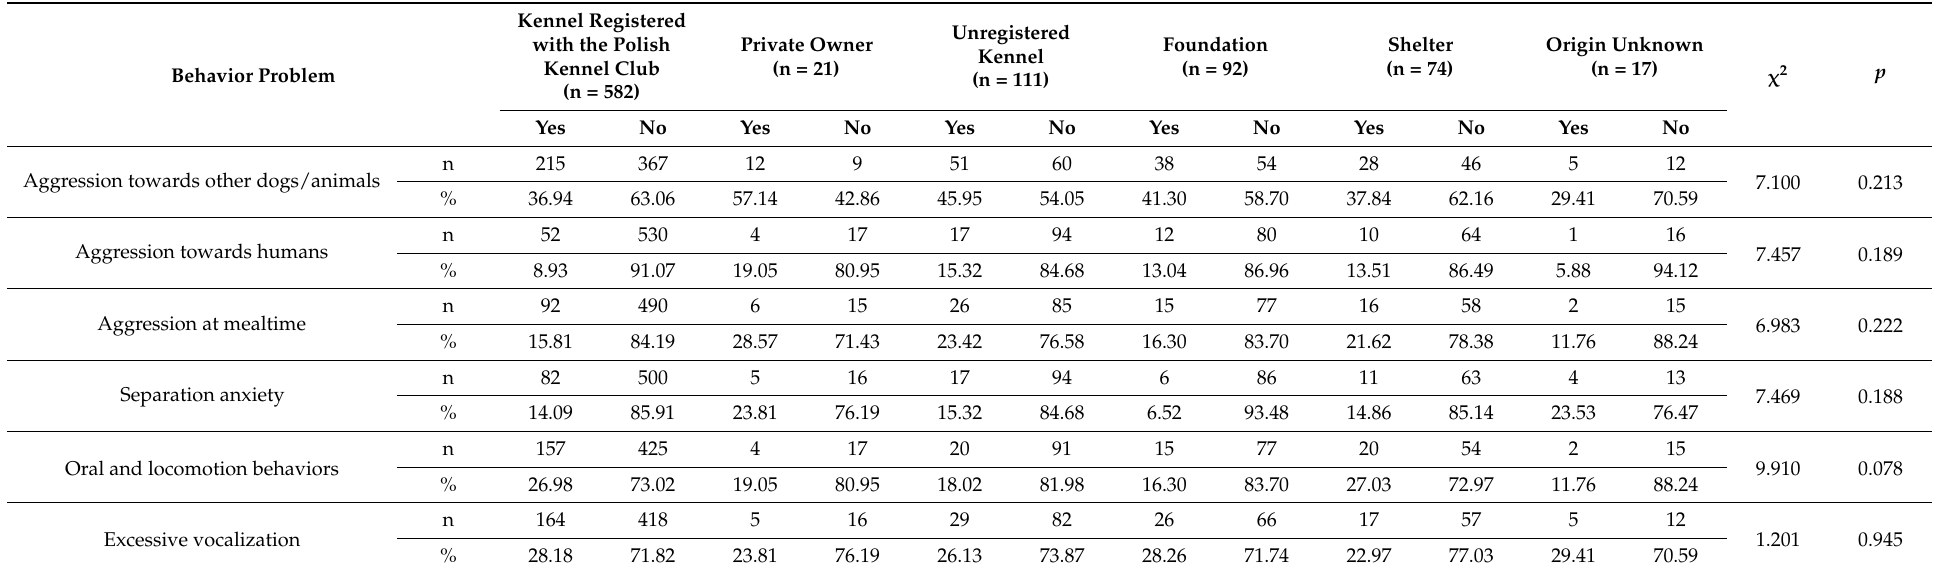
Table 4. The influence of origin on the incidence of undesirable behaviors in ancient dog